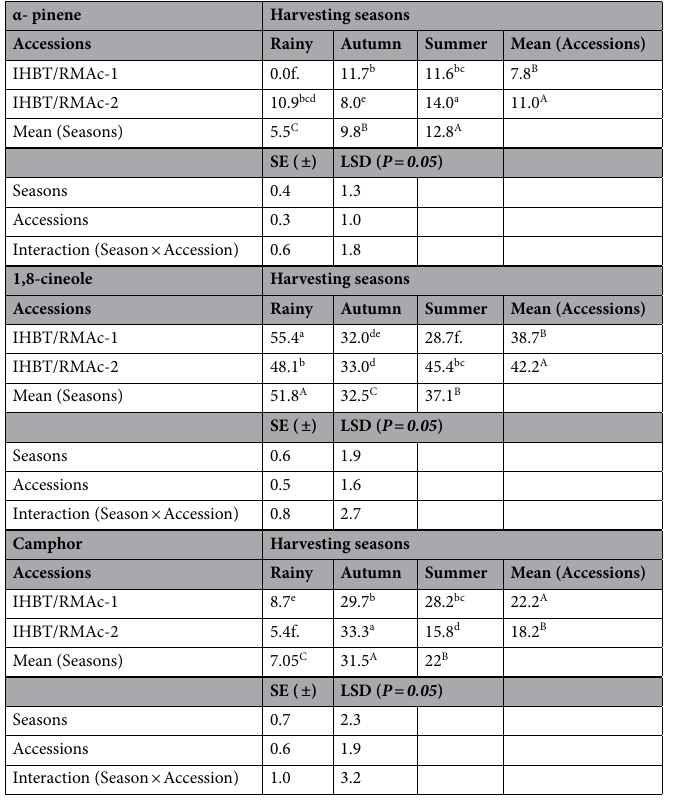
Table 3. Effect of season and accession and their interaction on major essential oil constituents of R. officinalis . Means with the same lower case superscripted letter indicate the interaction effect and means with similar superscripted letter did not differ significantly ( P = 0.05); values indicated with upper case superscripted letter are the means and different upper case superscripted letters indicate significant difference ( P = 0.05).